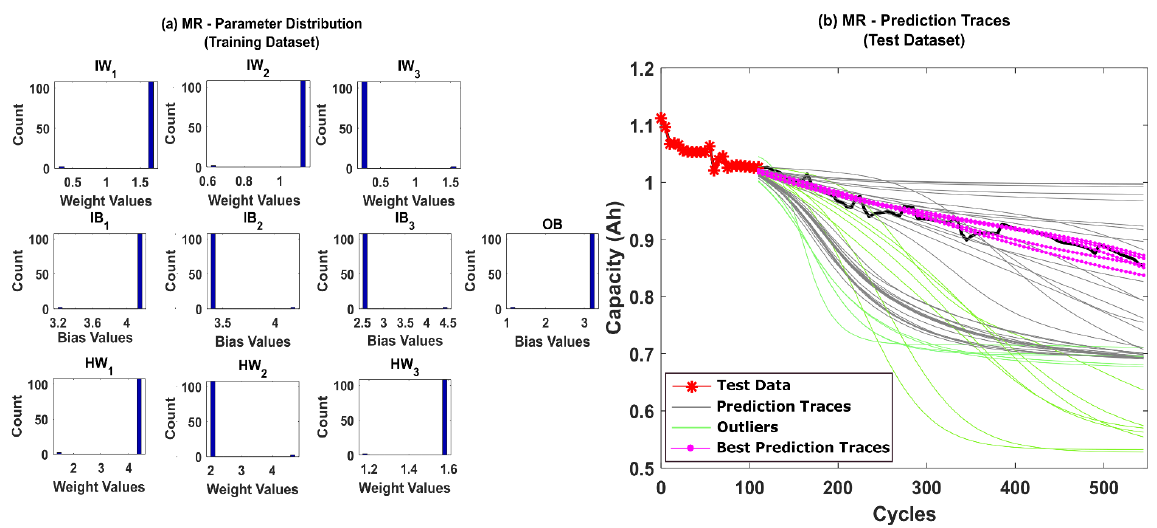
Figure 6. ( a ) The posterior distribution of MLP network parameters estimated by the adaptive Bayesian learning framework using MR and ( b ) the degradation prediction traces for CALCE battery (CS-37) using MR. The prediction traces for 50 repetitions are shown using the gray lines, the green lines represent outliers, and the magenta lines represent the traces with minimum RMSE val- ues.